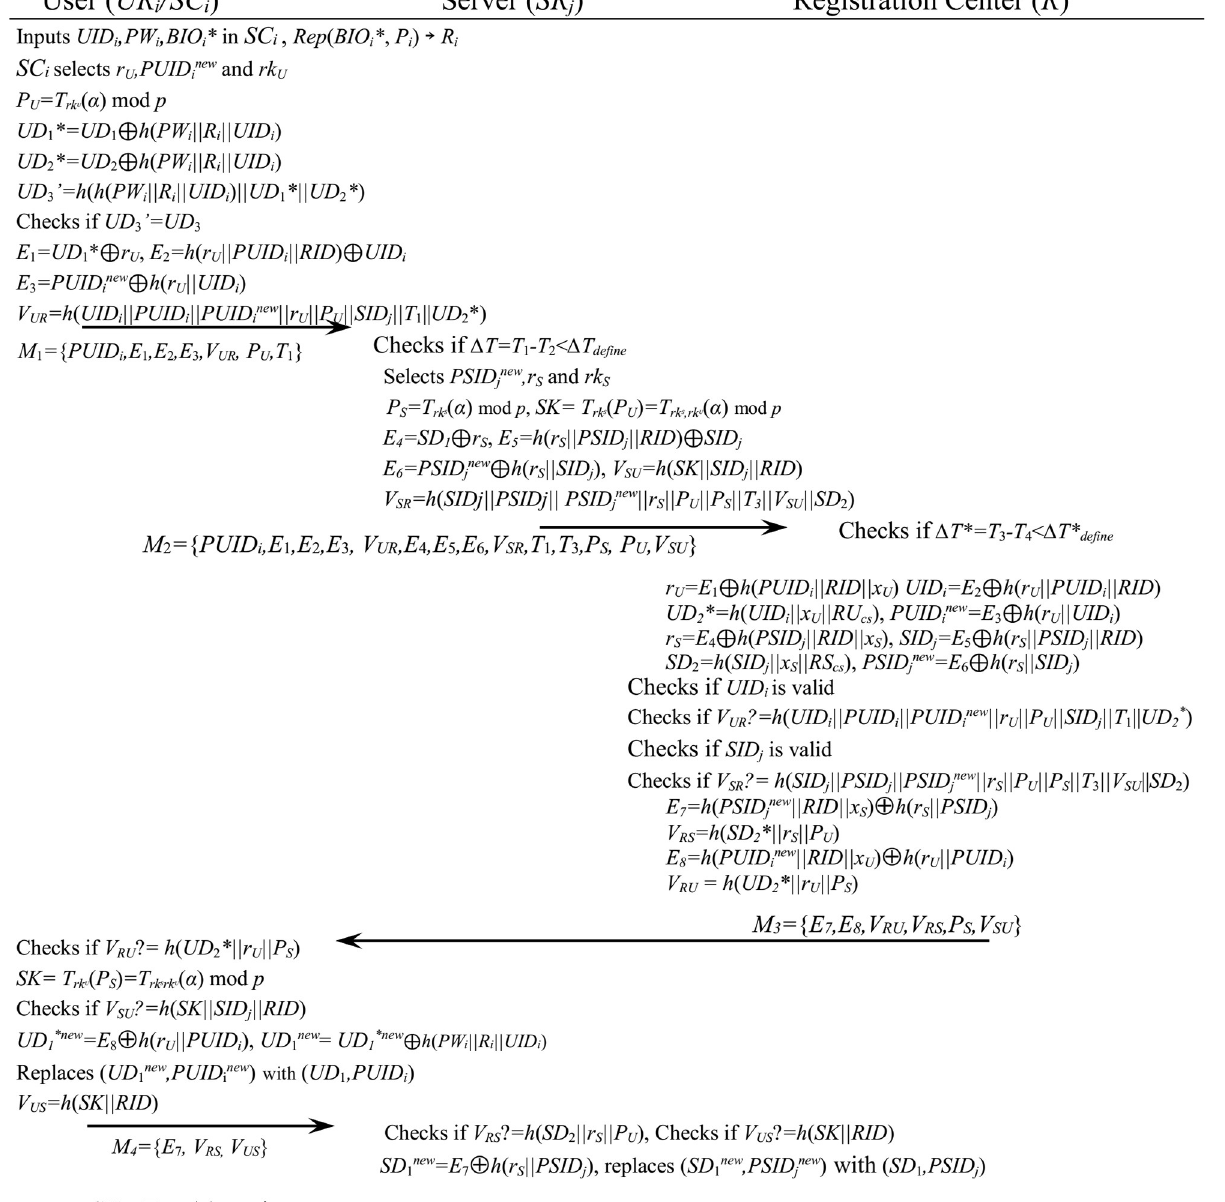
Step 3 : And R computes Δ T � = T time on R ). If Δ T � is greater than Δ T �